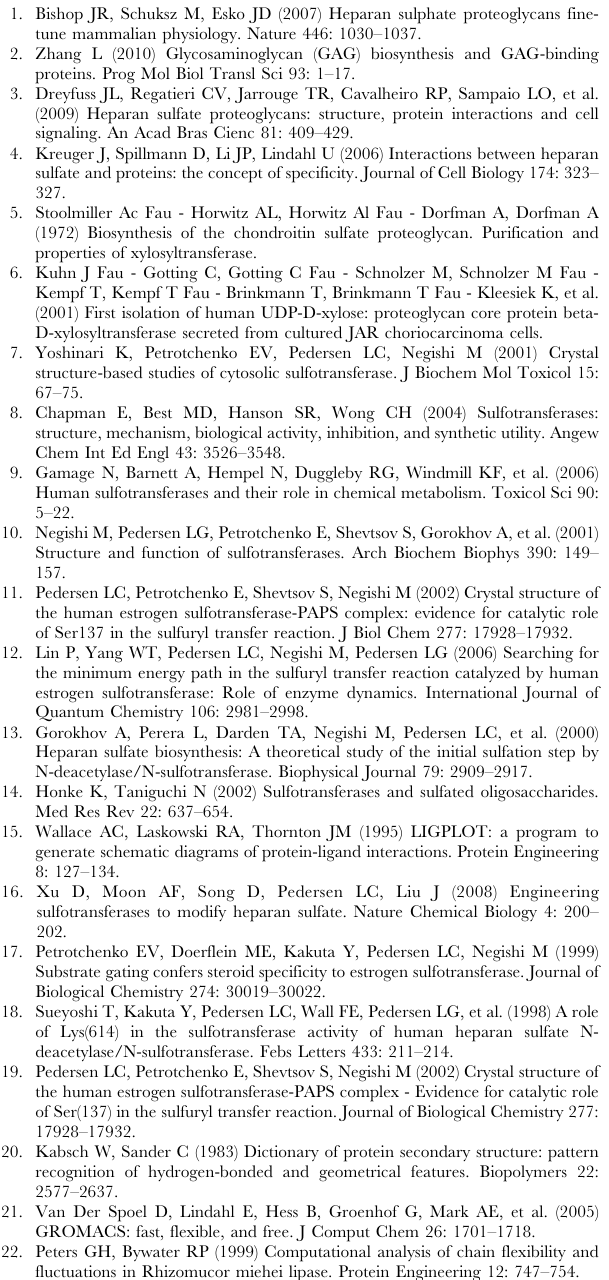
Figure S7 Projection of trajectory onto the plane of first four eigenvectors. Black; NST/PAPS/ a -GlcN-(1 R 4)-GlcA and red, NST/PAP/ a -GlcNS-(1 R 4)-GlcA. (TIF) Table S1 Validation docking for 3-OST -3(PDBiD 1T8T) with heptasaccharide as obtained by Autodock 4.2 (Energy unit: